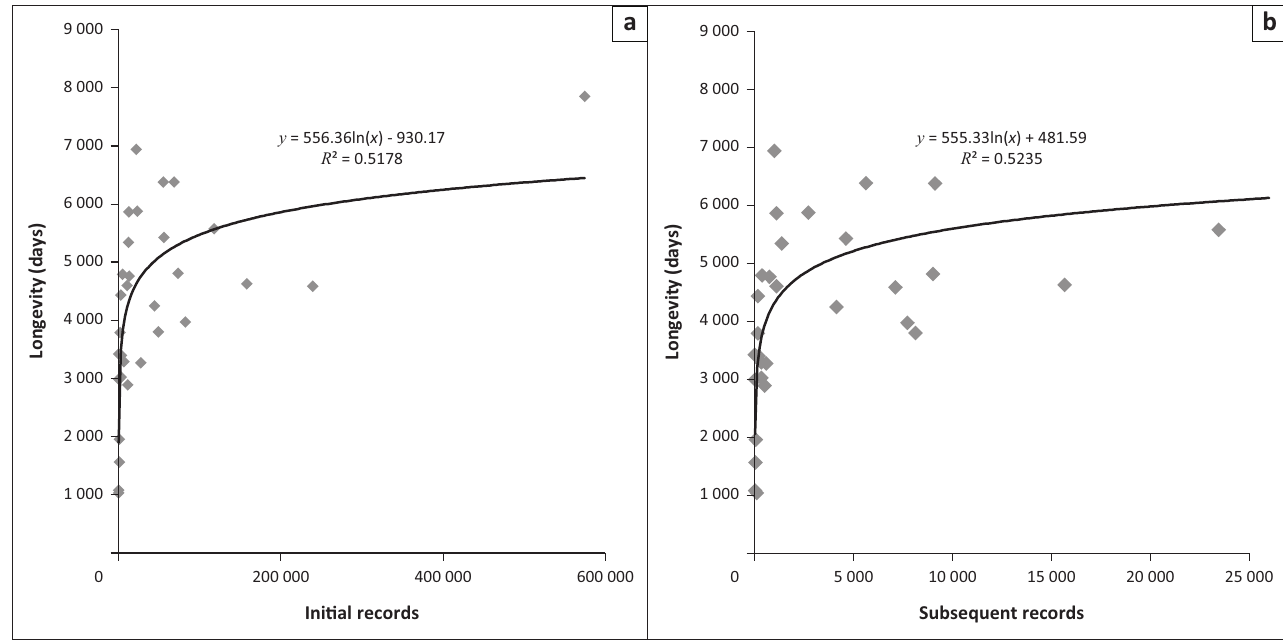
FIGURE 4: Number of (a) initial and (b) subsequent records compared to maximum longevity (days) of each Passeriformes family (logarithmic trend line